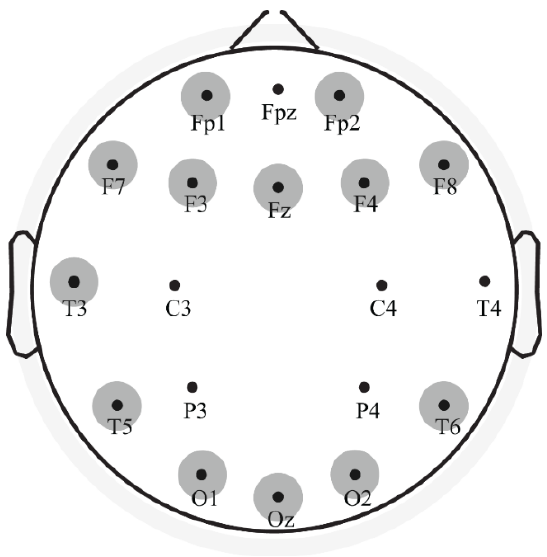
Figure 3. Results of the statistical analysis for the P200 component. The electrodes showing significant differences in latency between pre- and post-SD are indicated by the highlighted circles. Table 1. Mean ± SD of the P200 peak latency and amplitude in pre- and post- SD. A